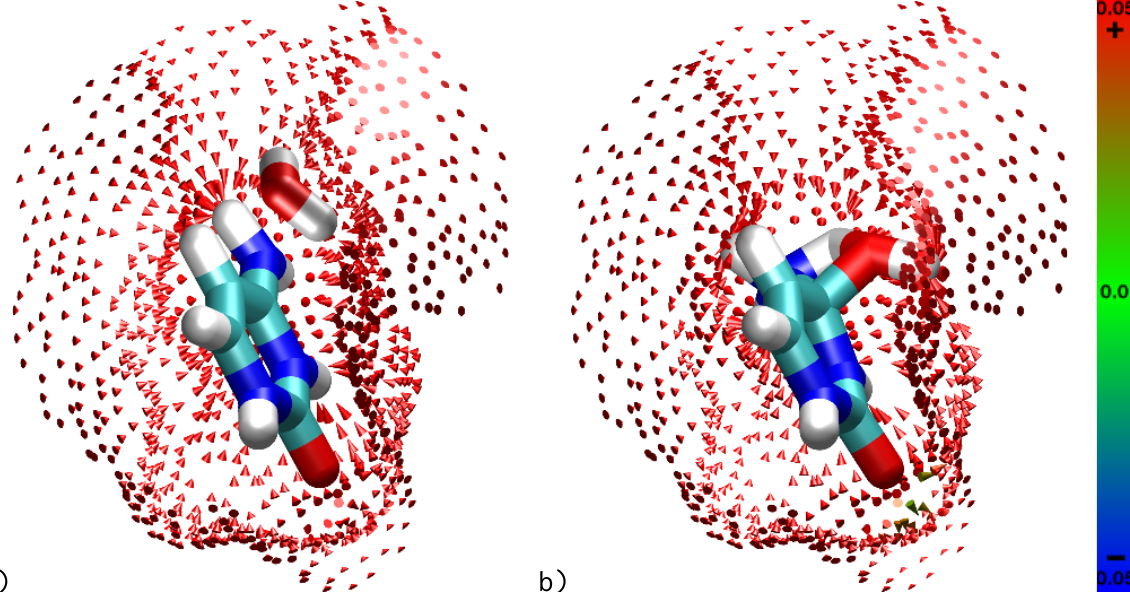
Figure 3: a) Substrate complex (cytosine + H substrate is protonated (+1) causing highly positive molecular electrostatic potential in the proximity. The molecular electrostatic potential is color-coded and the electrostatic field vectors are represented as